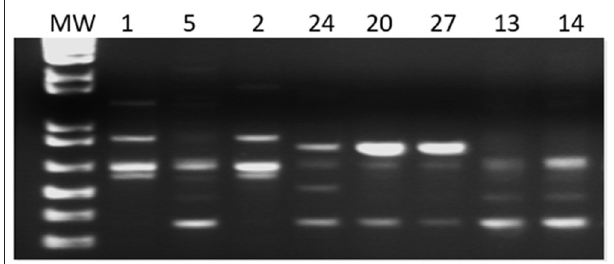
FIGURE 1 | Gel representative of the amplified products of the LSSP-PCR. MW–Molecular Weight: 1kb; 1, 5, 2, 24, 20, 27, 13, and 14 patient